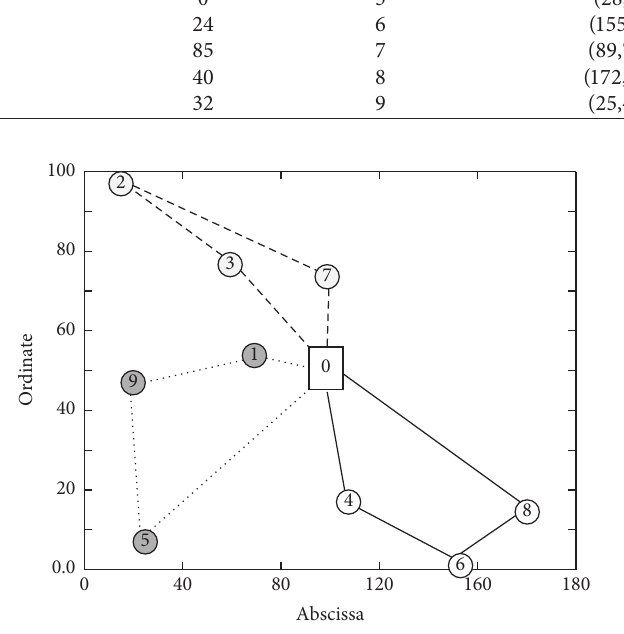
Figure 6: Optimal path graph of the proposed method. Table 2: Test results of different